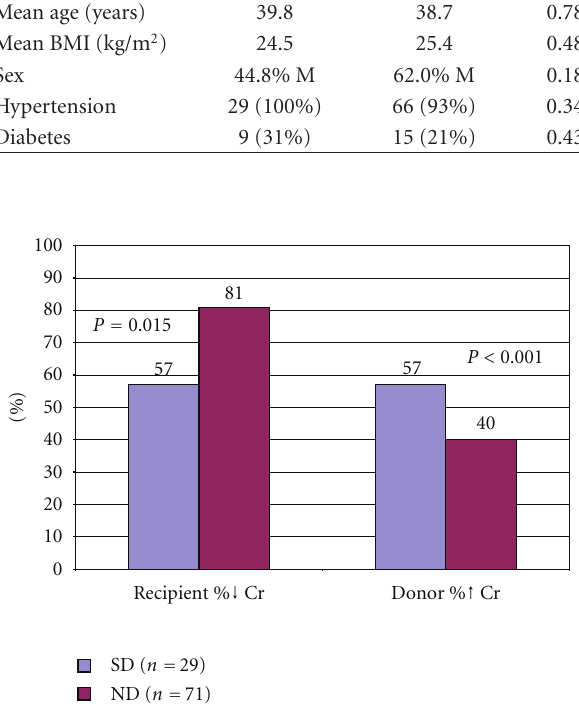
Figure 1: Comparison of percent change in creatinine (Cr) at most recent followup between recipients of kidneys from donors with a history of tobacco use (SD) and those with no history of tobacco use (ND) as well as the percent change in Cr of the donors.